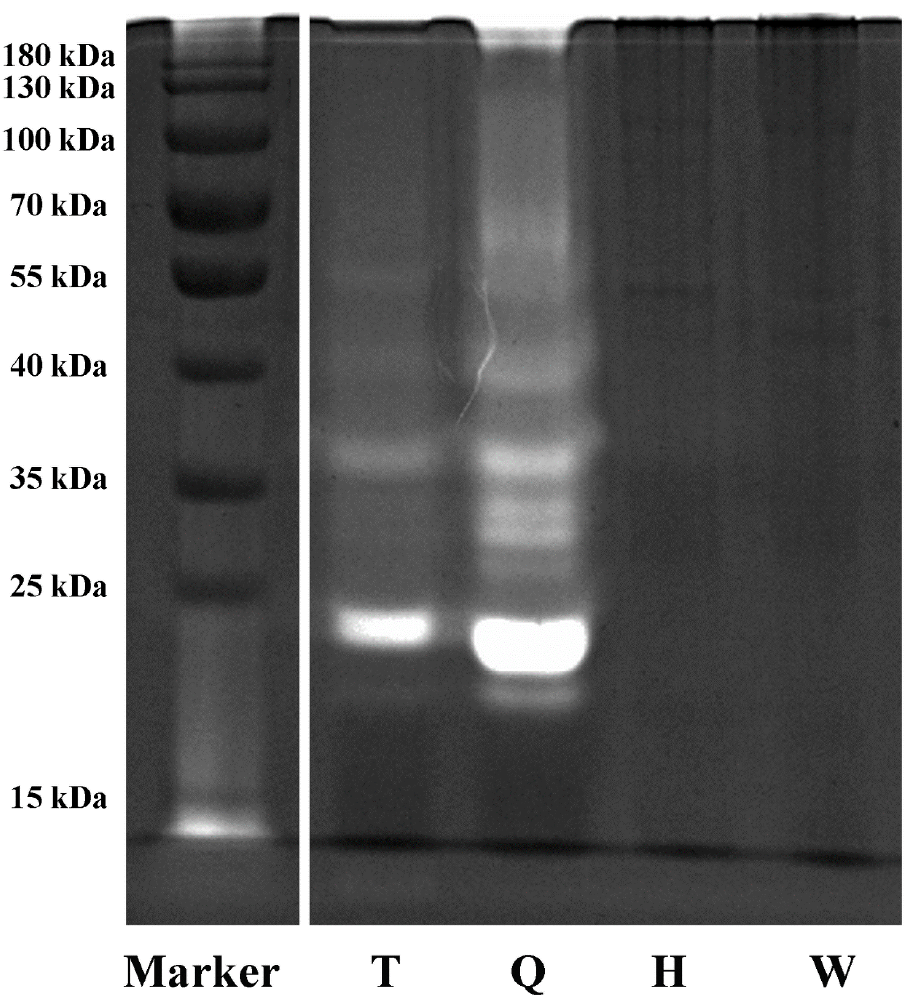
Figure 3. The fibrinogen zymogram of different PA portions (T: anterior portion of the PA, Q: anterior-midportion of the PA H: mid-posterior portion of the PA, W: posterior portion of the PA). Fibrinogen zymography was carried out using a 12% polyacrylamide gel that had been prepared in the presence of fibrinogen (0.5 mg/mL) and thrombin (0.012 BP/mL). We loaded 2 μ L samples (5 mg/mL) that were diluted with sample loading buffer without reducing agent into a fibrin gel.